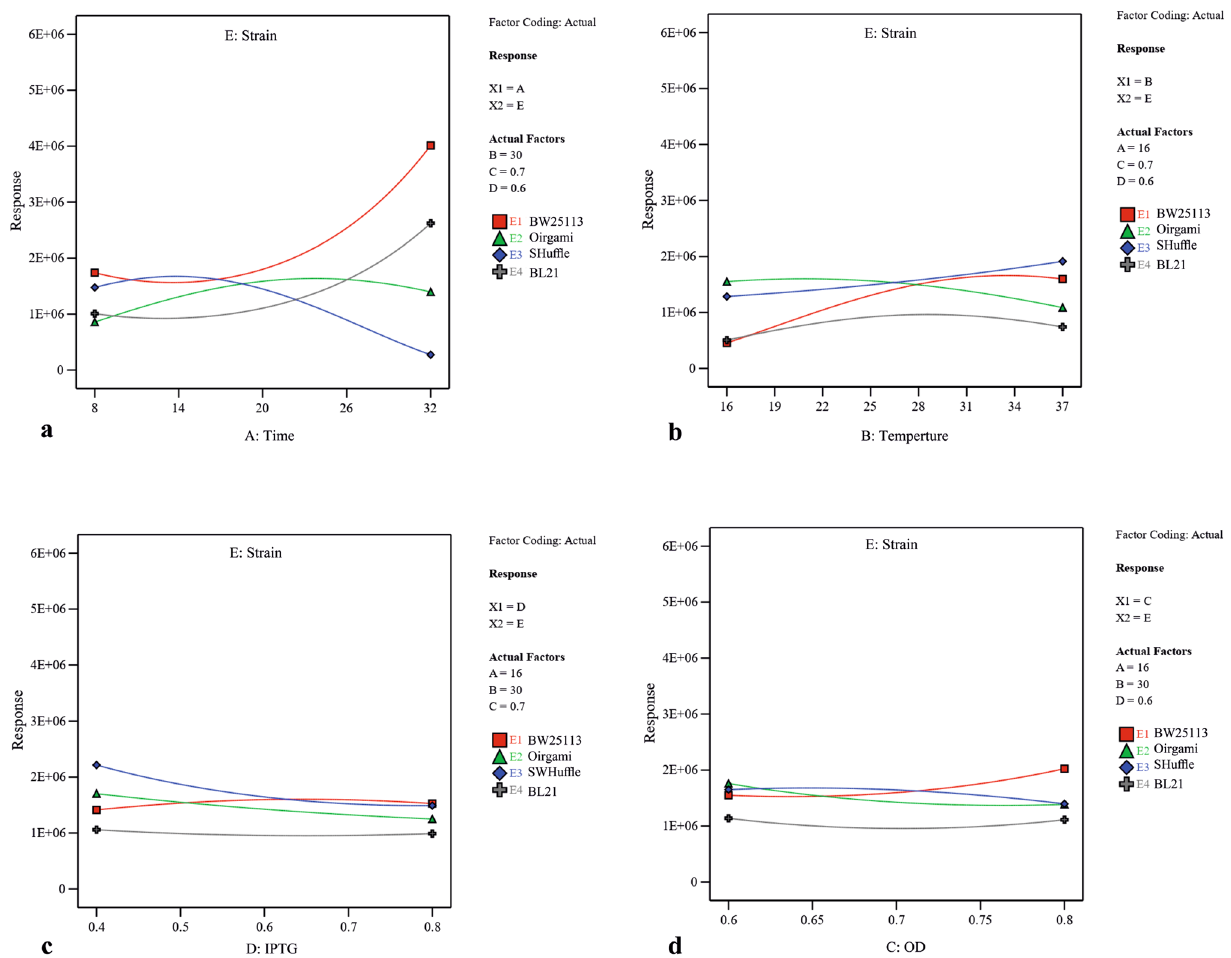
Figure 4. The interactive effects between strain type and ( a ) post-induction time ( b ) post-induction temperature ( c ) inducer concentration and ( d ) cell density of induction time. In each case other three numerical factors were kept at their constant middle levels (post-induction time (A), post-induction temperature (B), cell density of induction time (C), and inducer concentration levels of post-induction time (A) and optical cell density (C) were kept constant at their medium value (16 and 0.7 respectively), temperature raise could lead to increase the solubility in BW25113(DE3) and SHuffle T7. In BW25113(DE3), although increasing IPTG concentration at lower temperature decreased the amount of soluble fraction, an increase in inducer concentration at higher temperature had a positive effect on protein solubility. The dependency of OD600 nm before induction (C) and IPTG concentration (D) on scFv solubility when the post-induction time (A) as well as temperature (B) is kept constant (16 °C and 30 °C respectively) is illustrated in Supplementary Fig. S5. According to this graph, an increase in OD600 nm at higher IPTG concentration (0.8) led to a decrease in solubility in BL21(DE3) and SHuffle T7 and at lower inducer concentration (0.4), increasing the OD600 nm enhanced protein solubility. Interestingly, Supplementary Fig. S5 also declares that increasing the OD600 nm at both IPTG concentration levels leads to a solubility increase in BW25113(DE3) and decrease in Origami(DE3). The interactive effects between each independent numerical variable and strain type were studied while keeping other three numerical factors at their constant middle levels. As depicted in Fig. 4 and confirmed by ANOVA results, post-induction time was the most effective factor on soluble production of scFv in four strains studied here. Artificial neural network modeling. Using artificial neural network (ANN) models, the behavior of nonlinear multivariate systems can be predicted. The multilayer feed forward neural network with Quasi-Newton algo- rithm was the model considered for the present work. In this study, the same DoE used in building the RSM model was also employed to develop the ANN-based model. The experimental data was divided into three sub- sets including training, testing and validation (70%, 15%, 15% of data respectively) (Table 3). A small amount of noise was added to the data set and regularization of weight was done to prohibit overfitting the training data and make smoother responses. The network topology developed for ANN determines the accuracy of a model prediction. To achieve optimal ANN structure for prediction, the number of hidden layers and neural composi-